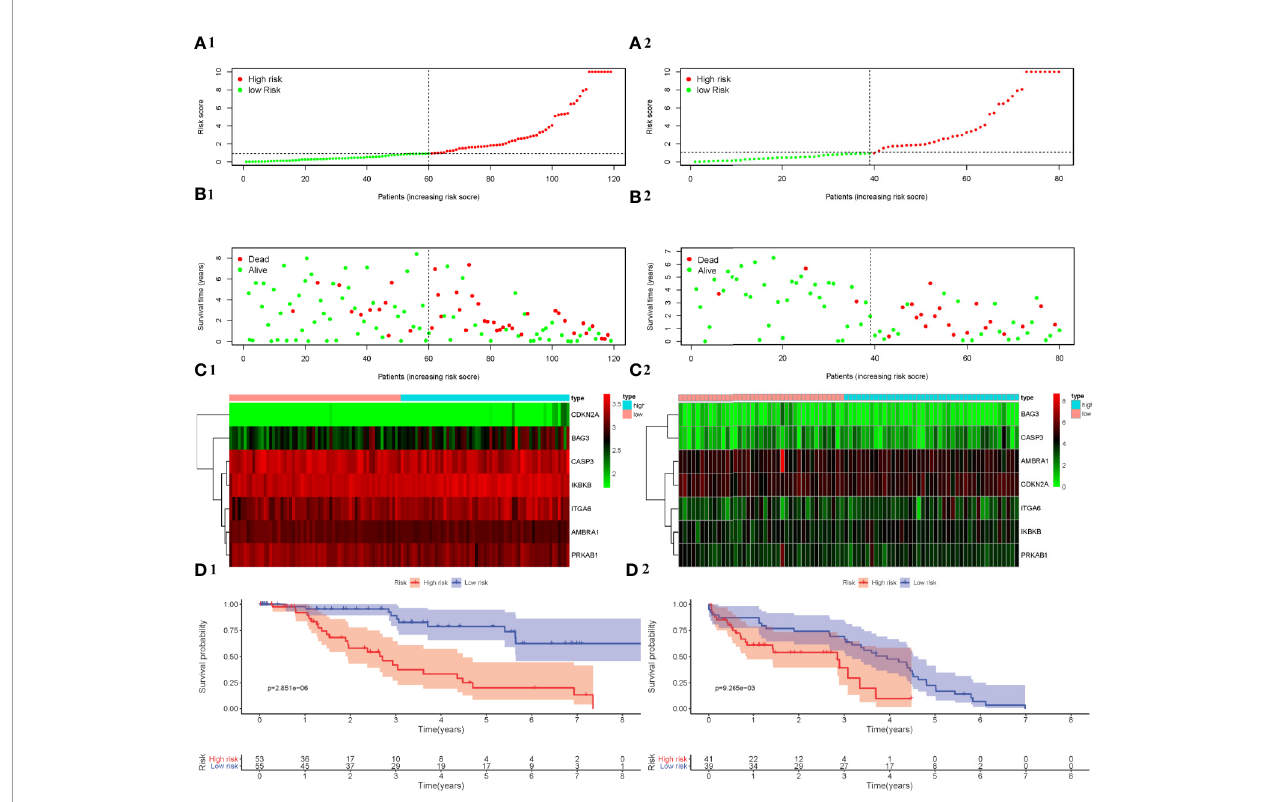
FIGURE 5 | Development and veri fi cation of a prognostic index based on ARGs. The distribution of the prognostic index in the training cohort is shown in (A1) and the validation cohort is shown in (A2) . The survival status of patients in the training cohort (B1) and the validation cohort (B2) . The expression pro fi le of ARGs in the training cohort (C1) and the validation cohort (C2) . Kaplan-Meier survival curves for the training cohort (D1) and the validation cohort (D2)